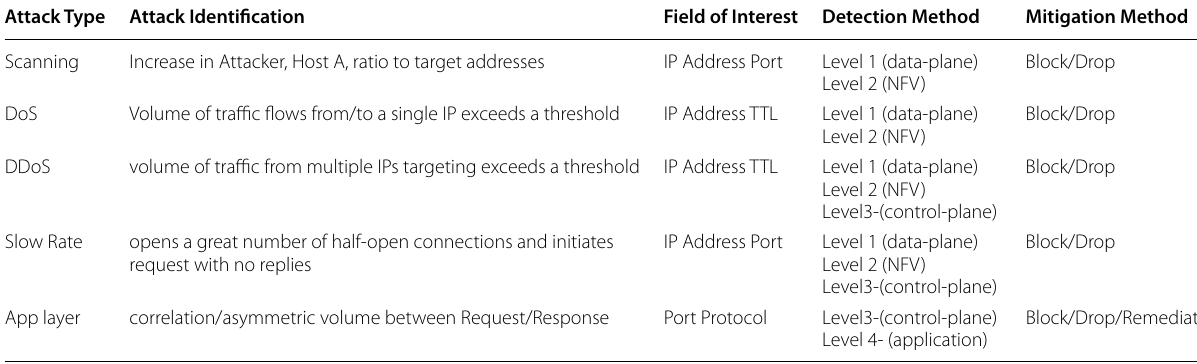
Table 10 Defense capabilities against the various classes of attacks Attack Type Attack